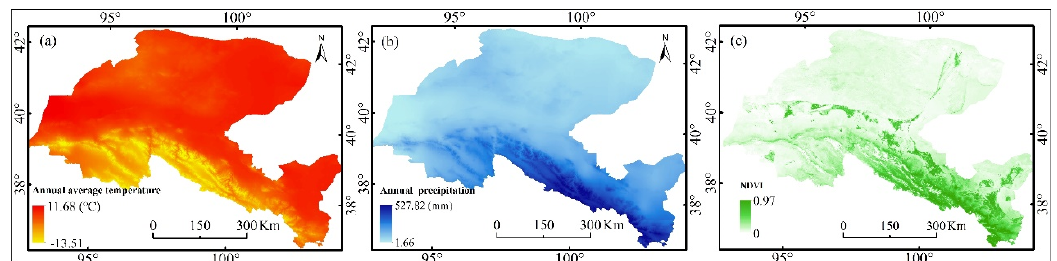
Figure 2. The spatial patterns of annual average temperature ( a ) and annual precipitation ( b ) in the Hexi region. The multi-year monthly precipitation and temperature gridded datasets over the period 1961–2000 obtained from the National Science and Technology Infrastructure [45] were summed and averaged, respectively, to generate the precipitation and temperature dataset shown in ( a ) and ( b ), respectively. ( c ) represents the maximum gNDVI (normalized difference vegetation index average over the growing season) for the period 2001−2017.